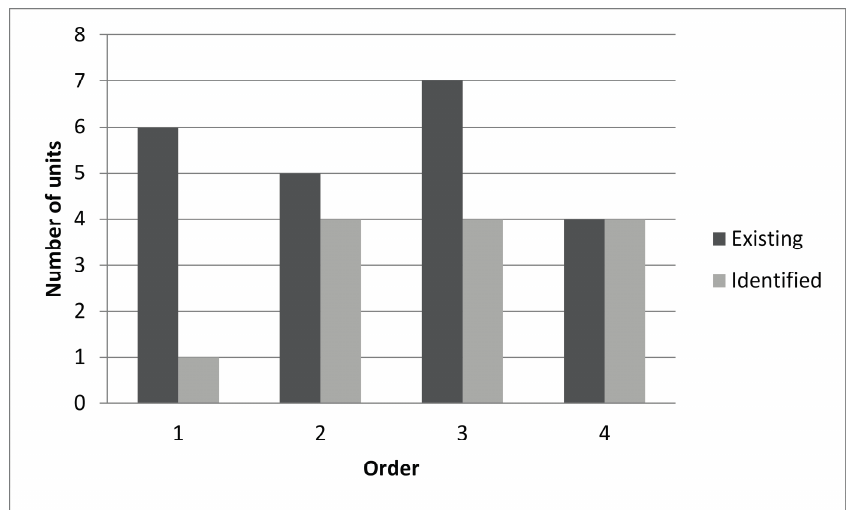
Figure 6. GlobalLand30-Water identified rivers following the categorization after Strahler [61], represented by the x-axis. The y-axis draws the number of 1st, 2nd, 3rd, and 4th order rivers. The total overlapping percentage of both timely upgraded HC LSW and DN compared with the respective ones of GlobalLand30-Water derived areas is 65.5%. It was calculated by dividing the total GlobalLand30-Water overlap area into the total LSW + DN area. Contrarily, GlobCover 2009, GlobCorine 2009, and GLCNMO 2008 accuracies drop significantly to 37.1%, 45.1% and 27.6%, respectively, if the DN areas are included in the accuracy assessment (Figure